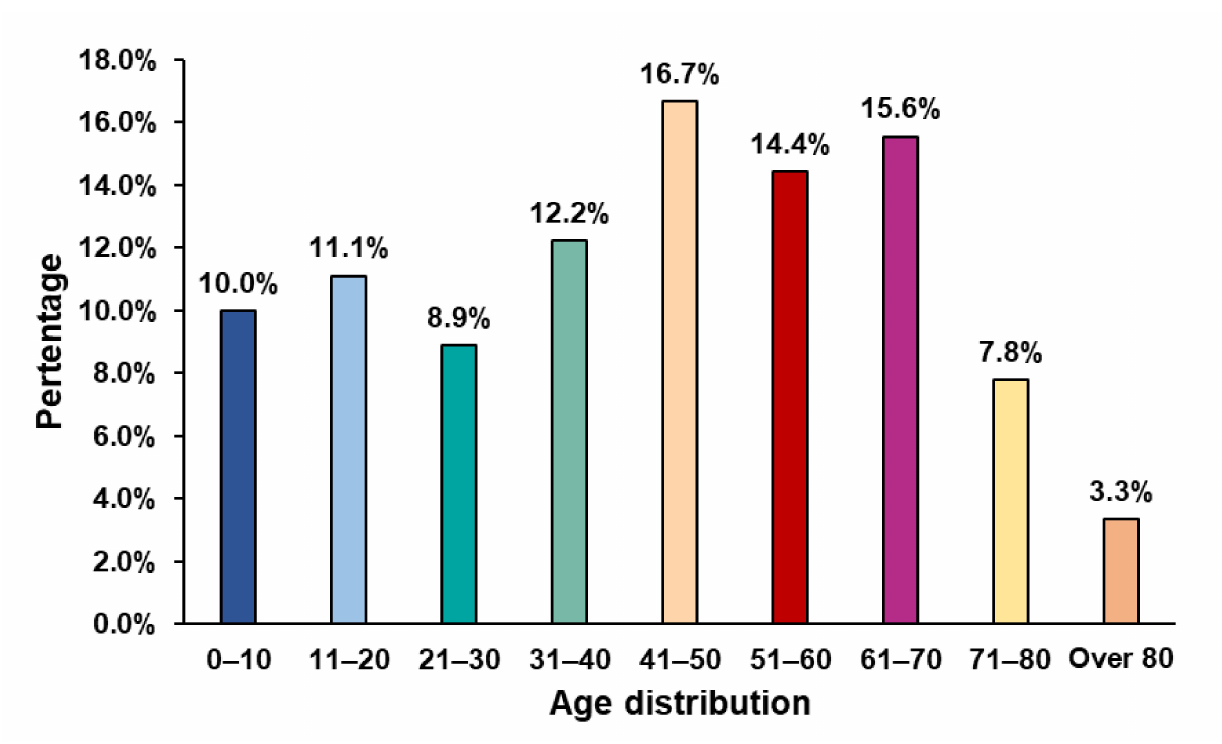
Figure 2. Age distribution of COVID-19 patients with encephalitis. A majority of the studies were reported on European (37.2%), followed by Asian (30.8%) and North American (23.1%), COVID-19 patients. Of these patients, 31.9 were healthy, without any past medical history of illness. Among the reported levels of severity of the COVID-19 patients, 11.7%, 38.3%, 11.7%, and 38.3% of the patients were denoted as asymptomatic, mild, moderate, and severe, respectively. Interestingly, the onset of encephalitis-associated symptoms was manifested in 78.0% of the COVID-19 patients as an initial presentation. Seizure (29.5%), confusion (23.2%), headache (20.5%), disorientation (15.2%), and altered mental status (11.6%) were the most frequently reported neurologic manifestations. Among the types of diagnosed encephalitis, a majority were confirmed to be SARS-CoV-2-associated or -mediated encephalitis (59.3%), followed by autoimmune encephalitis (18.7%). Among the included patients, 66.7% were discharged (37.8% im- proved, 28.9% fully recovered, and 12.2% patients were discharged without reporting their outcomes), whereas 20.0% of the reported COVID-19-positive encephalitis patients died. Looking at the MRI, EEG, and CT scan findings, 77.6%, 75.5%, and 64.1% of the patients presented with abnormal results, respectively. All the diagnostic features of the COVID-19 patients with encephalitis are presented in Tables 2 and